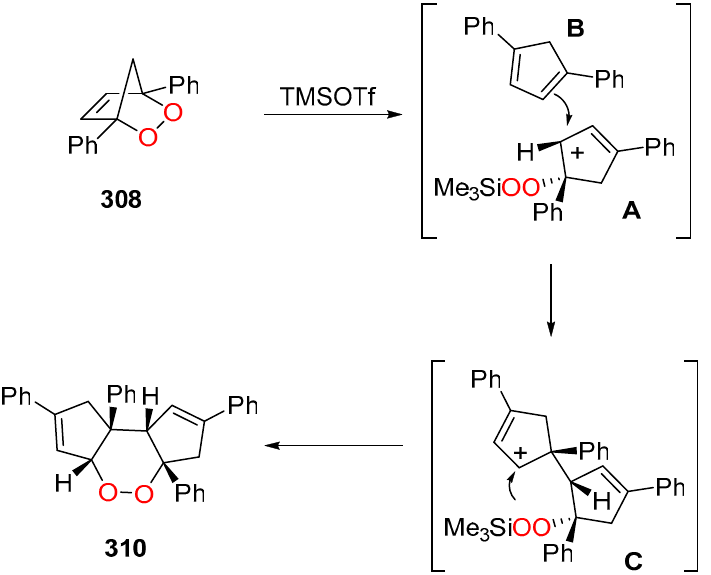
Scheme 113. The proposed mechanism for the assembly of tetrasubstituted 1,2-dioxanes 310